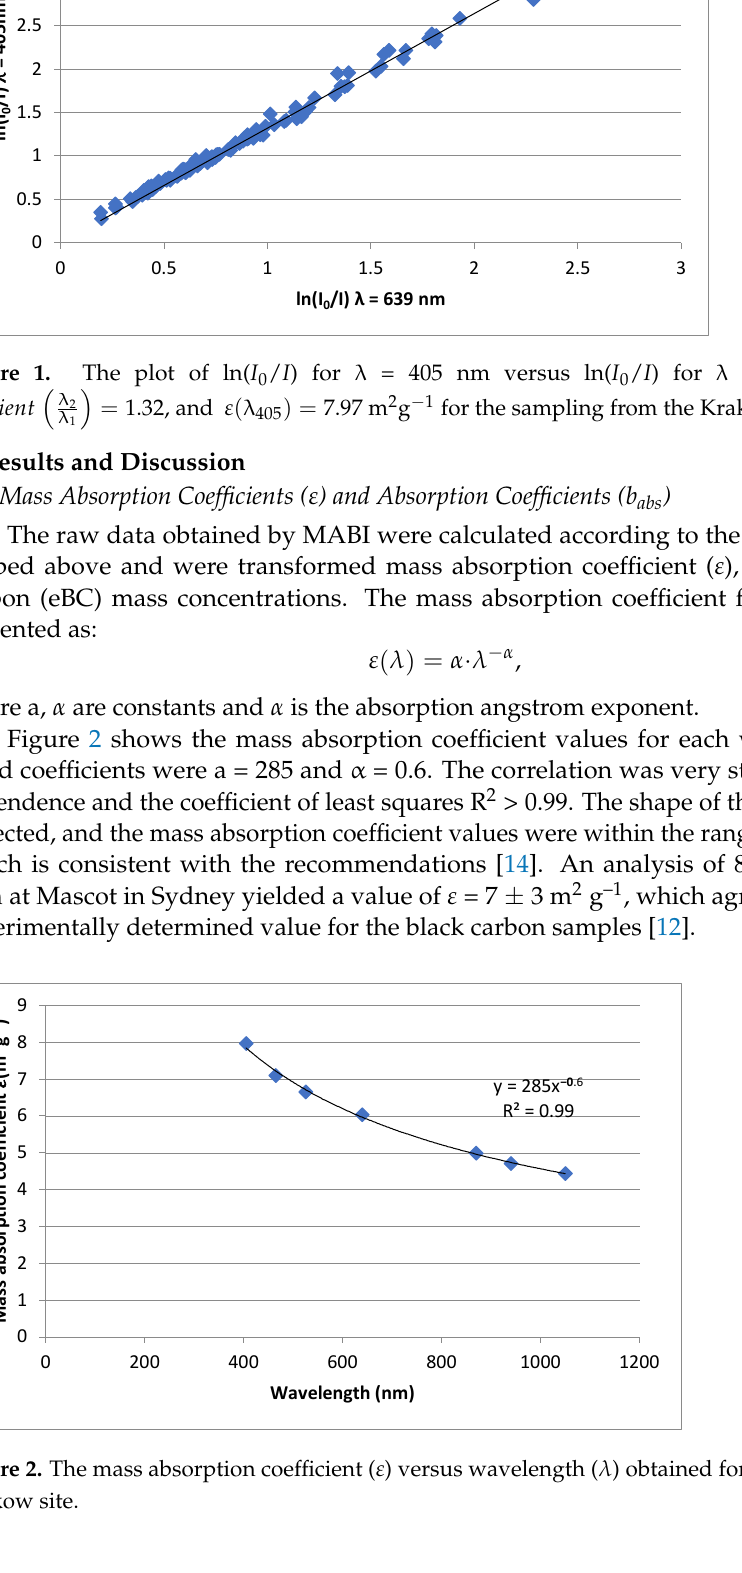
λ 2 𝑔𝑔𝑔𝑔𝑔𝑔𝑔𝑔𝑔𝑔𝑒𝑒𝑔𝑔𝑔𝑔 � λ 1 � =